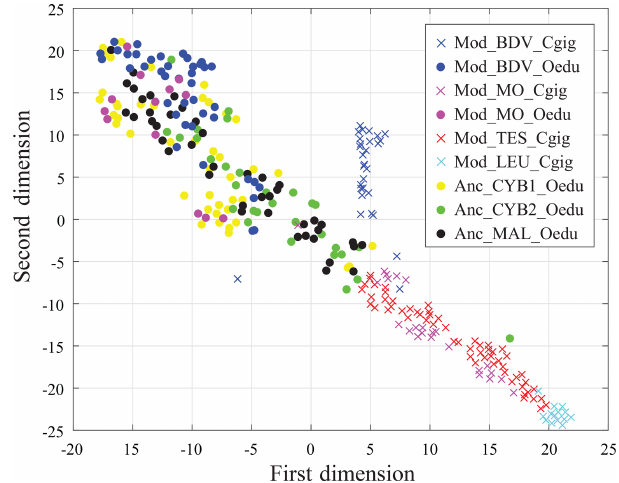
Figure 6. Visualization of shell group partitioning using t -SNE ap- plied to all REE and Y measurements as variables. Crosses and large dots refer to C. gigas and O. edulis ,